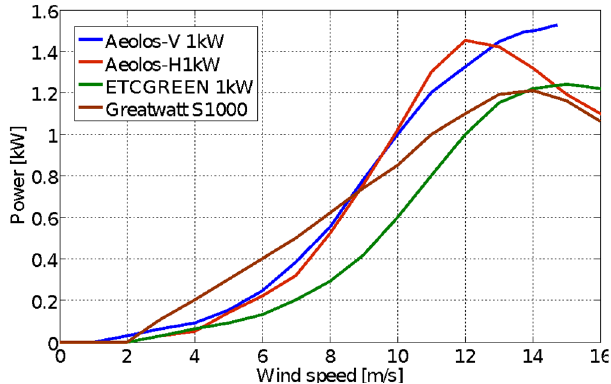
Figure 6. Power curves for the 1 kW turbines, [23].